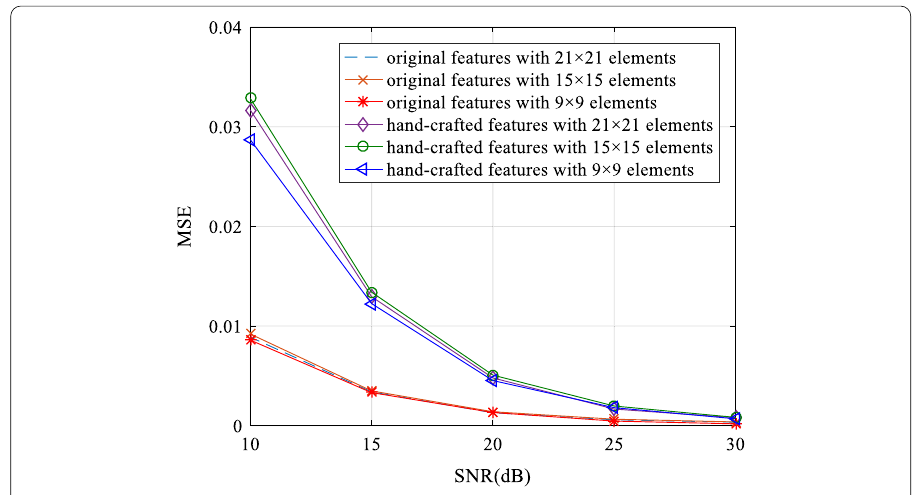
Fig. 10 The influence of the original and hand-crafted features